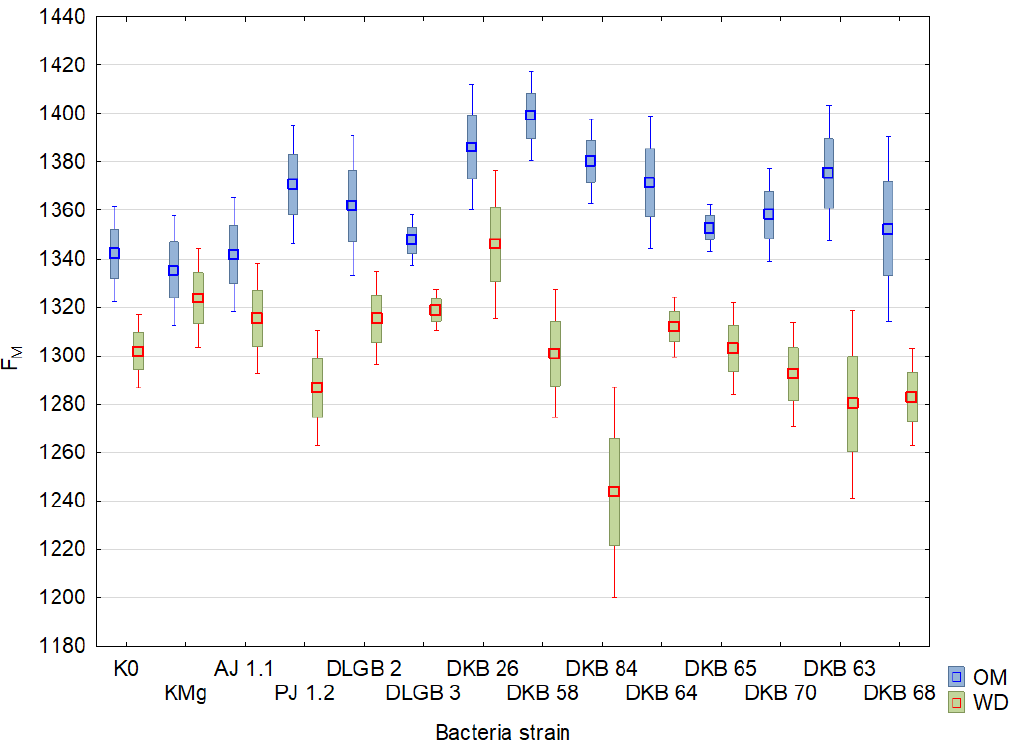
Figure 5. F M in the leaves of strawberry plants inoculated with rhizosphere bacteria growing under different substrate moisture levels, where: OM — optimal moisture, WD — water deficit.